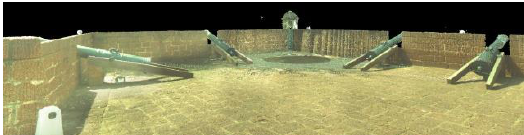
Figure 8. The coloured point cloud data of the top part of the monument